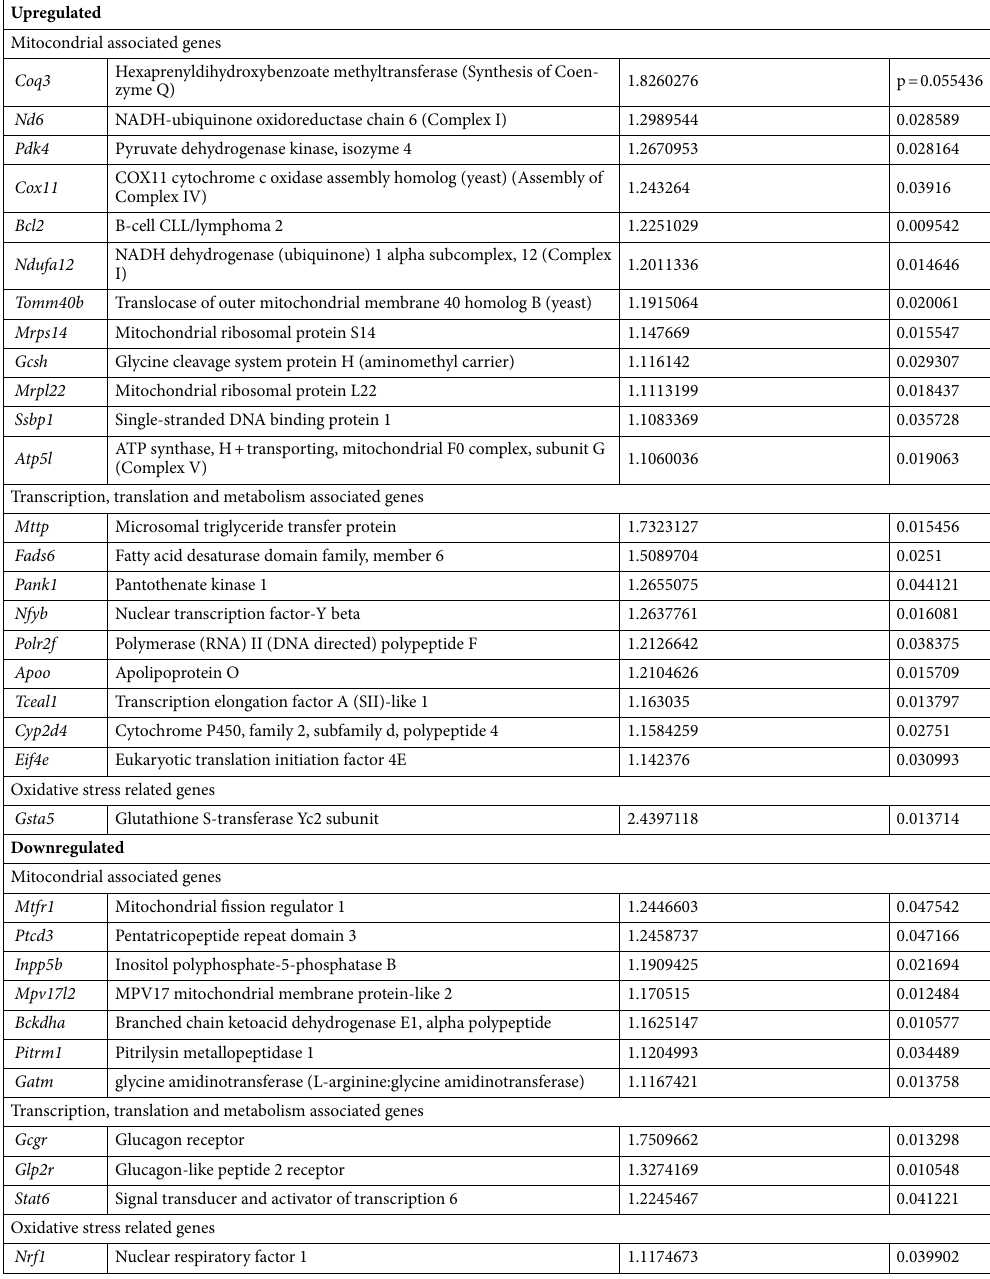
Table 1. List of genes showing significant fold change in microarray. Selection of relevant genes from the Agilent Microarray analysis from animals fed with KD compared to CD fed animals. Table shows the mitochondrial related genes; transcription, translational metabolism genes; and oxidative stress associated genes for which expression significantly changed (p < 0.05) (with the exception of Coq3 that with a p = 0.0554 was included in the selection as the gene we believe is relevant for the